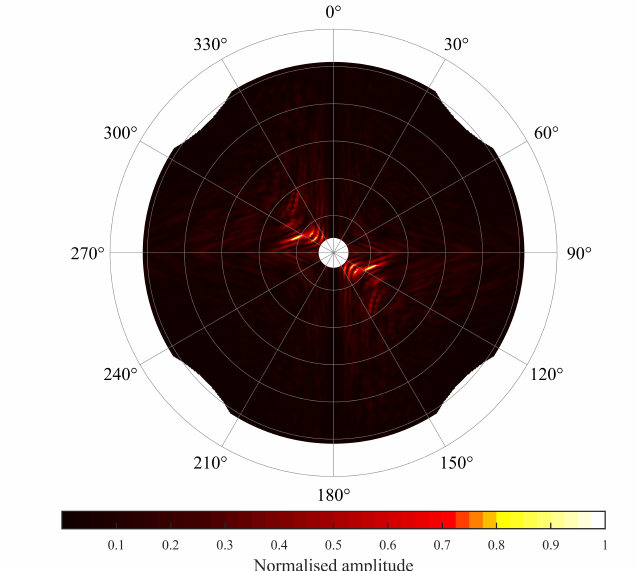
Figure 7. Full Radon spectrum derived from Sentinel-2 imagery that was sensed on 30 March